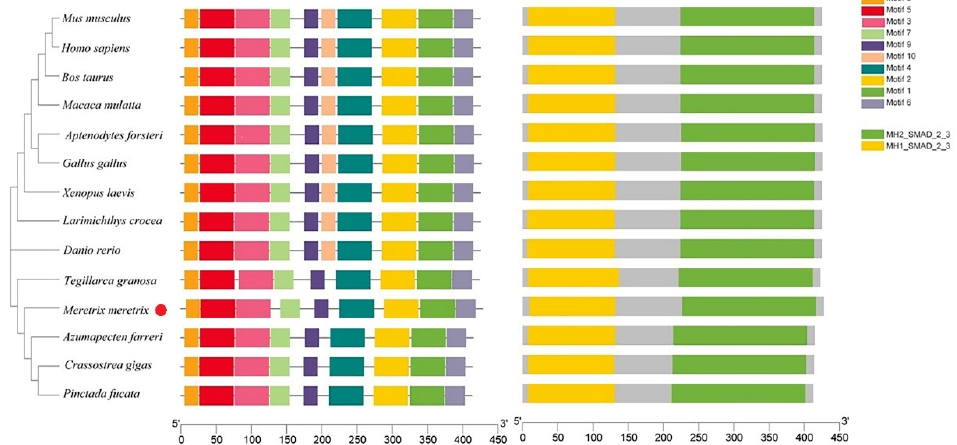
Figure 3. The structure of Smad3 of clams, other bivalves, and vertebrates.